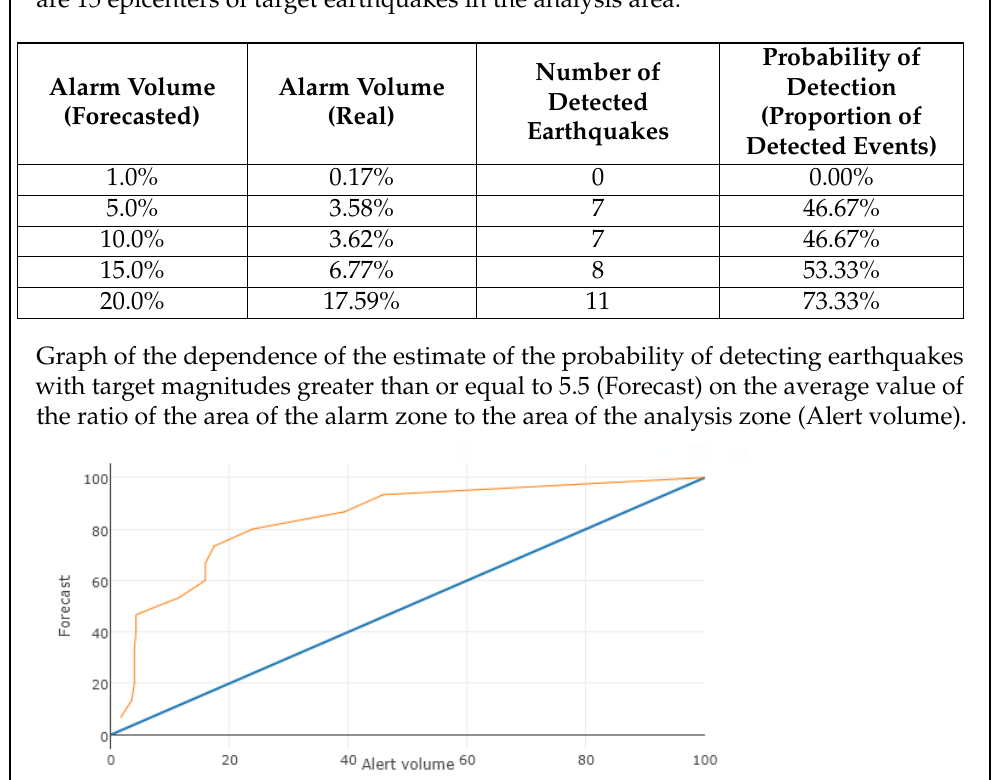
ment velocity estimates are ahead of the time of the values of the first station